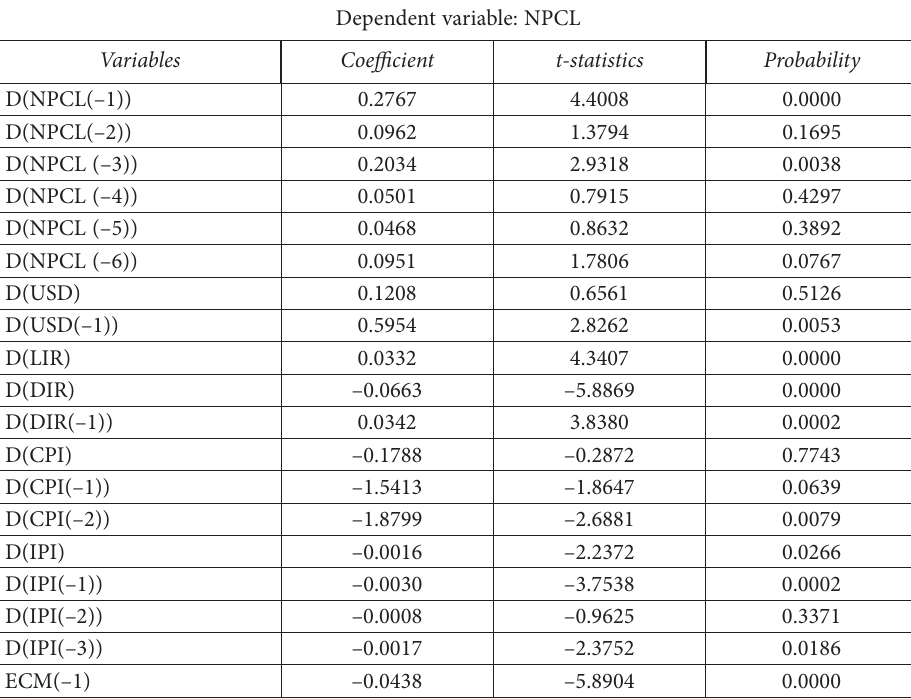
Table 6. Error correction model results (source: own calculation of